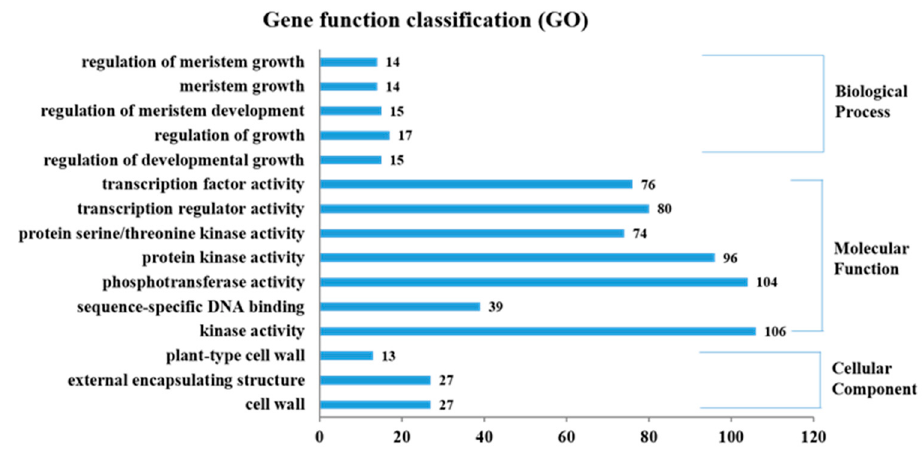
Figure 3. Gene ontology (GO) terms enriched in differentially expressed genes.